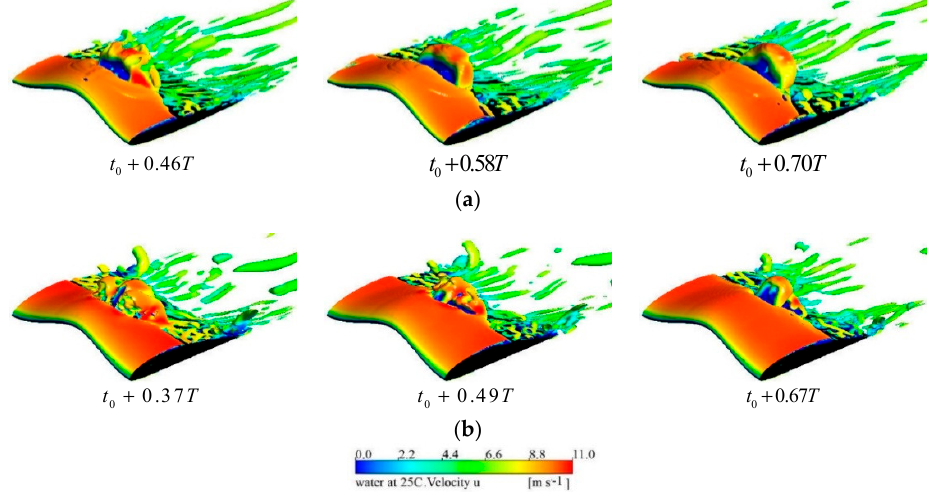
Figure 9. Comparisons of vortex strucutres on the suction side of hydrofoils during the cavity shedding process: ( a ) NACA0009; and ( b ) Clark-y.